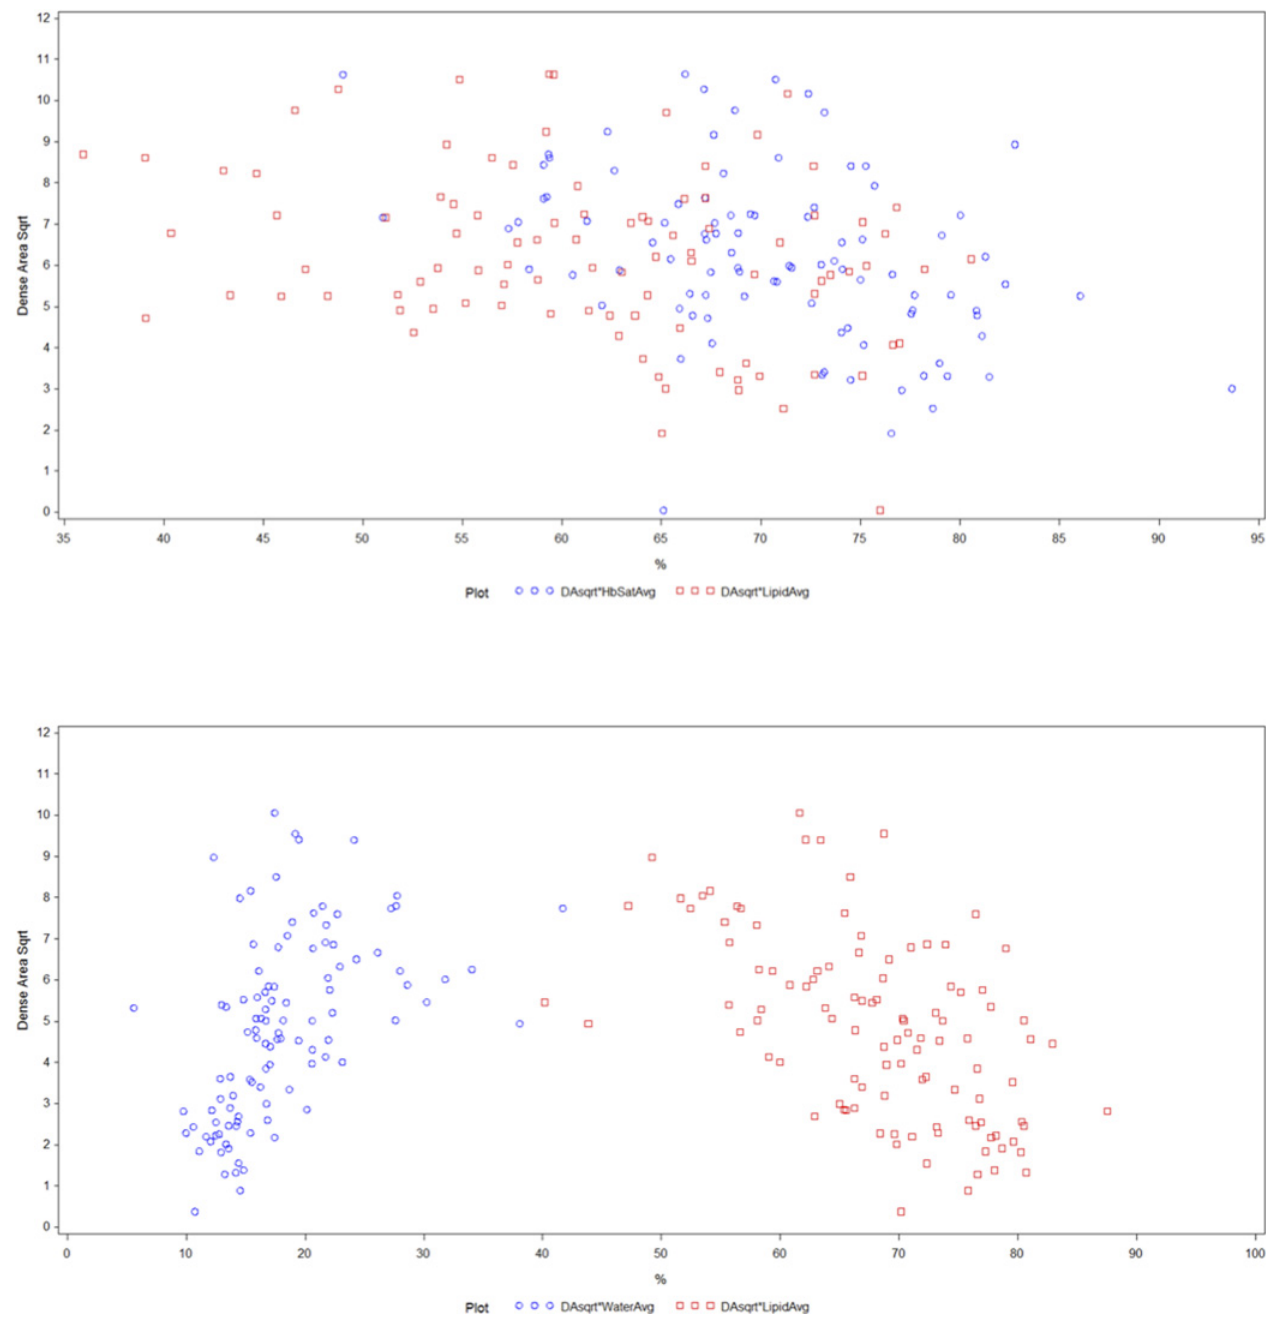
Figure 3. Scatterplot showing the final association of OS chromophore measures [lipid%(red square), water%(blue circle), S t O 2 %(green star)] with DA (square root transformed) in pre (top) and post-menopausal women (bottom).